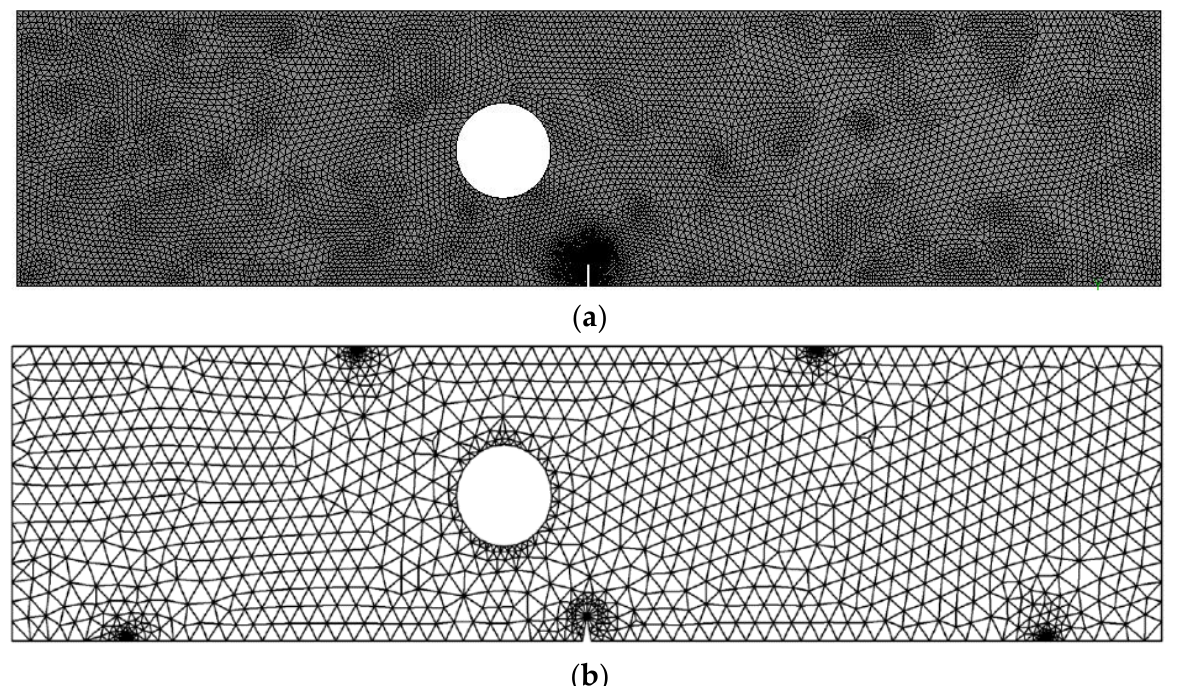
Figure 14. Adaptive mesh for the modified four-point bending beam, ( a ) dens mesh and ( b ) coarse mesh.